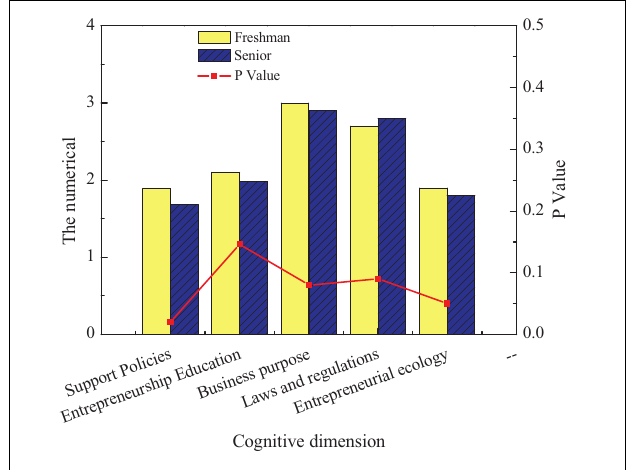
FIGURE 6 | Comparison of entrepreneurial cognition among students of different